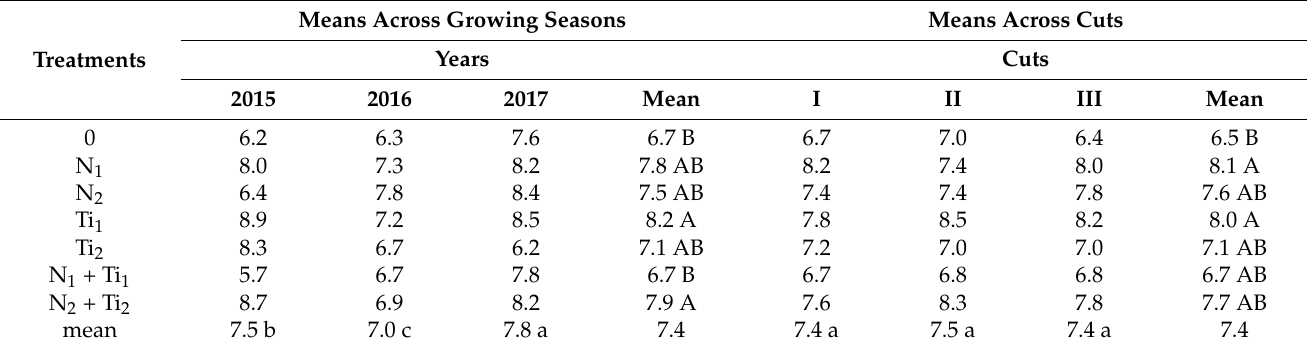
Table 4. Lignification rate of Festulolium braunii dry matter (%).